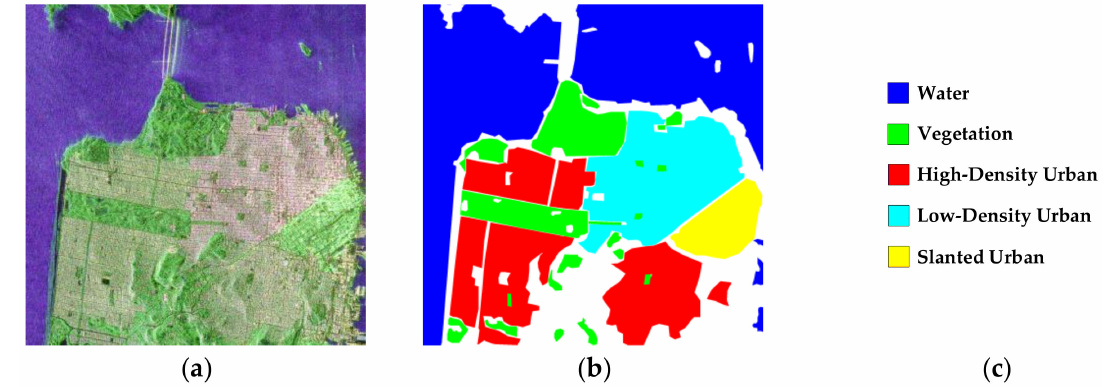
Figure 6. ( a ) Pauli-RGB image of dataset 3, ( b ) ground-truth [47] and ( c )